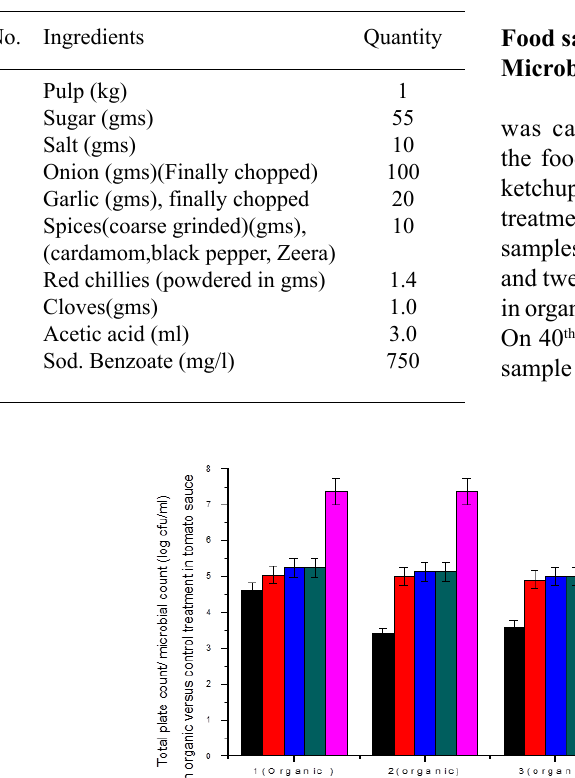
table 1. Details of the ingredients used for the preparation of sauce